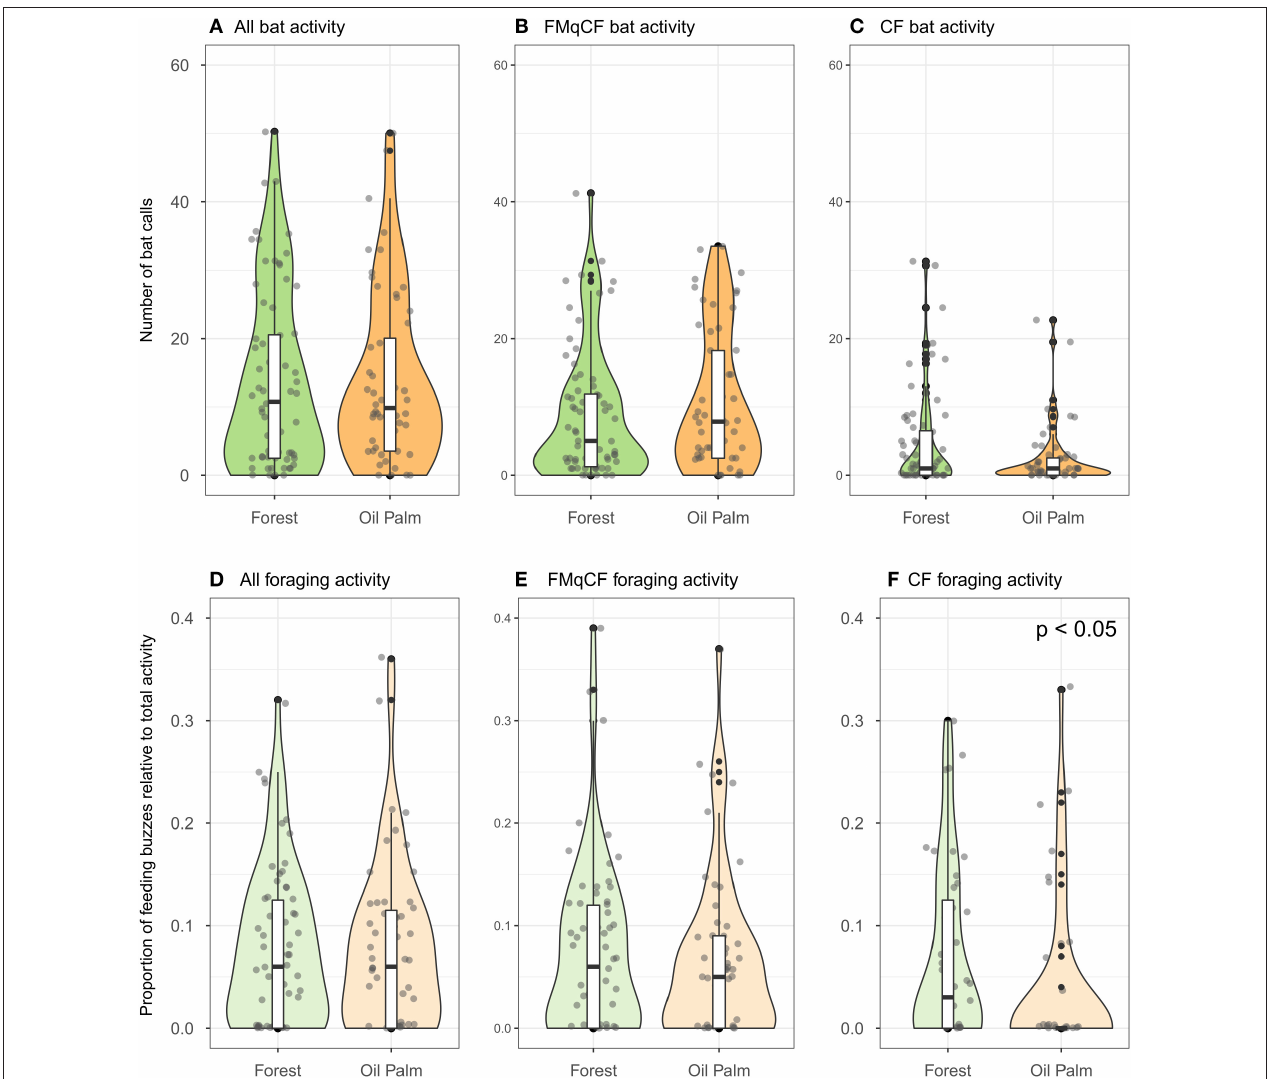
FIGURE 2 | Violin plots and boxplots demonstrating variation in bat activity and foraging activity between rivers in contiguous forest vs. those in oil palm for all species recorded in the study. Points represent bat activity per sampling point (Forest = 72 points across 9 sites; Oil palm = 56 points across 7 sites), and are jittered to improve presentation of the data distribution. (A–C) Represent bat total activity; (D–F) represent foraging activity.